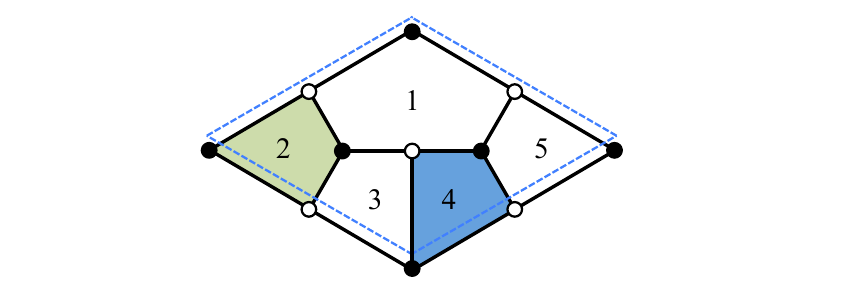
Figure 37. Phase 2 of dP 2 . We will consider an instanton on face 4 (blue) and Seiberg duality on face 2